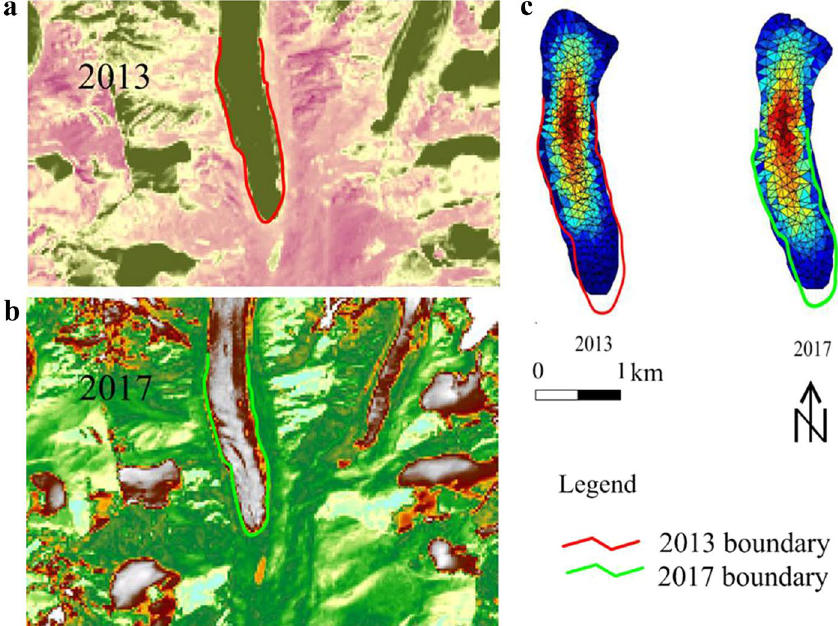
Figure 13. The overall of comparison of the simulation results with Landsat images (https://glovis.usgs.gov/). ( a ) Landsat image in 2013 and the map was plotted using ArcGIS 10.2 (http://www.esri.com/). ( b ) Landsat image in 2017. ( c ) Comparison of the simulation results with Landsat